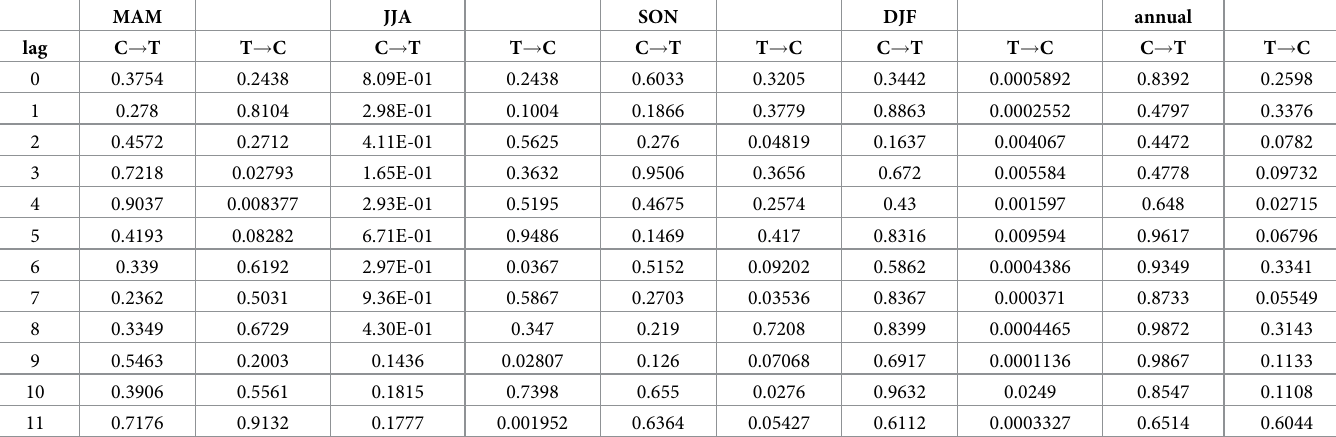
Table 2. P-values of the Granger test for causality between PDSI (C) and seasonal annual run-off (T) using variable lags between 0 and 11